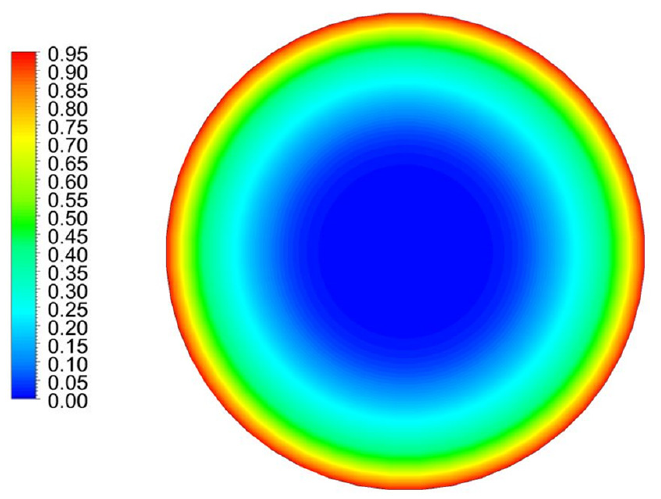
Figure 8. Void Contour at DNB (for tubes).